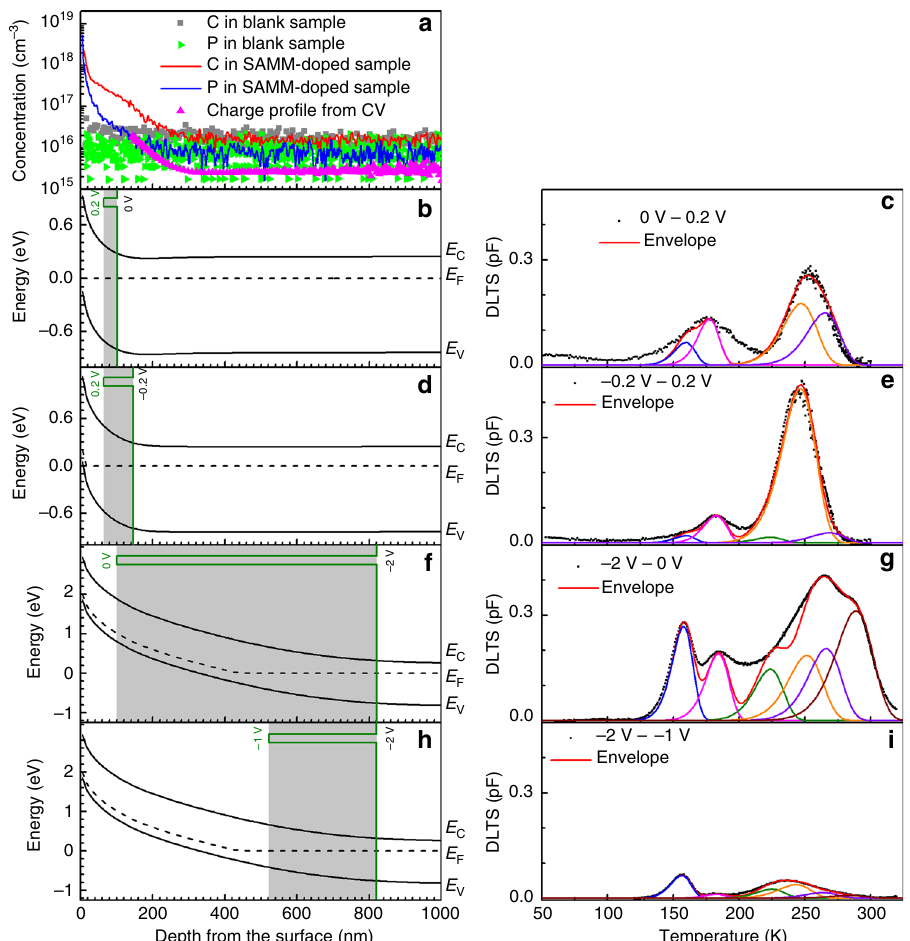
Fig. 6 DLTS probing region analysis. a Phosphorus and carbon depth pro fi les by SIMS compared with ionized charge pro fi le derived from CV. Silvaco simulation on band structure at 300 K with bias voltage of 0 V ( b ), − 0.2 V ( d ), − 2 V ( f ) and − 2 V ( h ). Probing regions are shaded in gray with different pulses from 0 to 0.2 V ( b ), − 0.2 to 0.2 V ( d ), − 2 to 0 V ( f ) and from − 2 to − 1 V ( h ). DLTS simulations on the spectra of the SAMM-doped silicon with pulses from 0 to 0.2 V ( c ), − 0.2 to 0.2 V ( e ), − 2 to 0 V ( g ) and − 2 to − 1 V ( i ). The rate windows of DLTS spectra are 200 s − 1 . Note that c , e , g and i have the same y axis scale for better comparison. A close-up fi gure for i to show the fi tting envelope can be found in Supplementary Figure